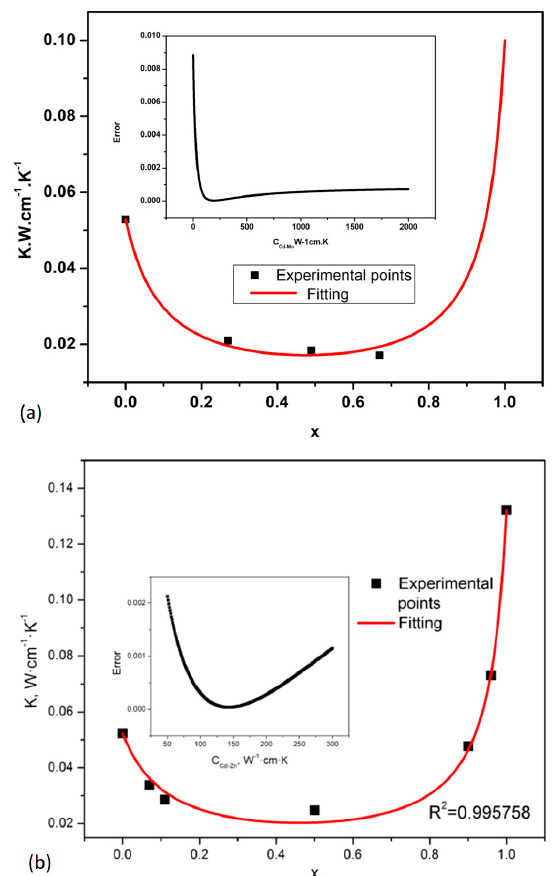
Figure 6. Thermal conductivity curve versus composition for CMT ( a ) and CZT ( b ) mixed crystals. The points are the experimental data, and the line is fitted and obtained using Equation (14). The error graphs from the least square approach are presented in the inset.